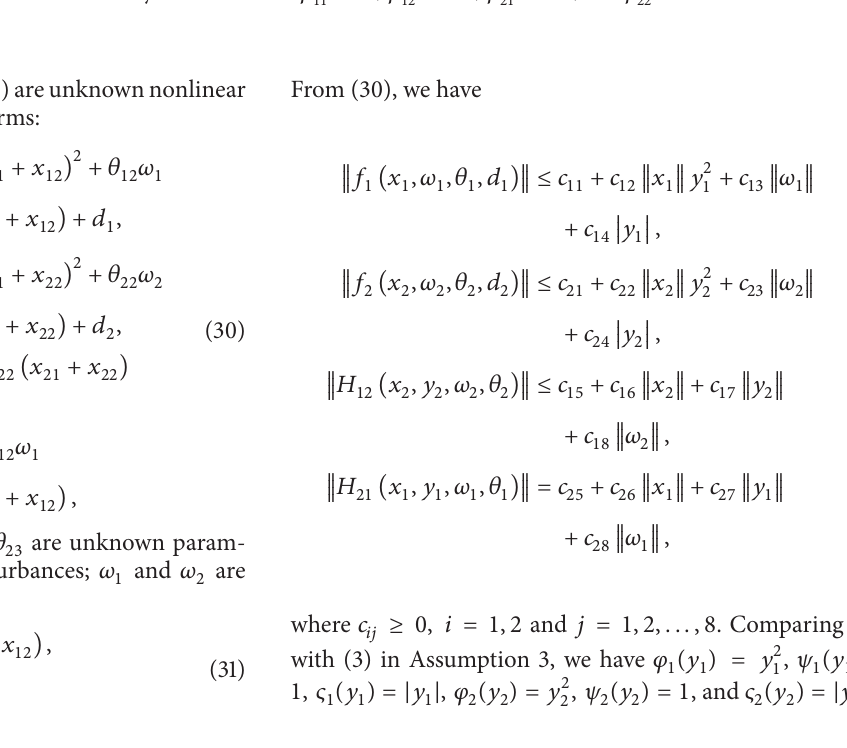
Figure 4: Simulation results of the system states with 𝛽 ∗ 11 = 80 , 𝛽 ∗ 12 = 100 , 𝛽 ∗ 21 = 120 , and 𝛽 ∗ 22 = 140